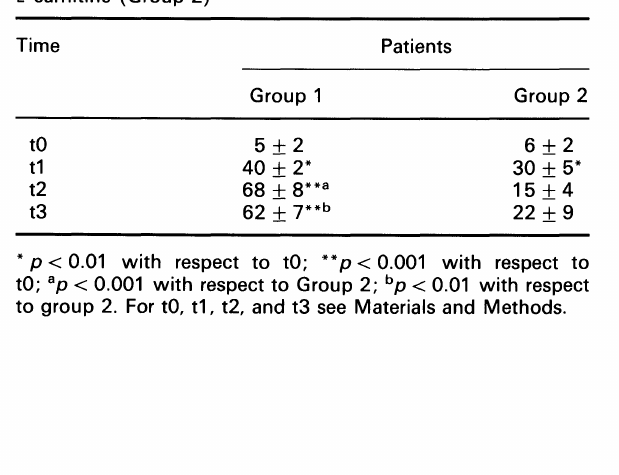
Table 1. Serum levels of TNF (pg/ml) following surgical/ anaesthetic trauma in patients receiving placebo